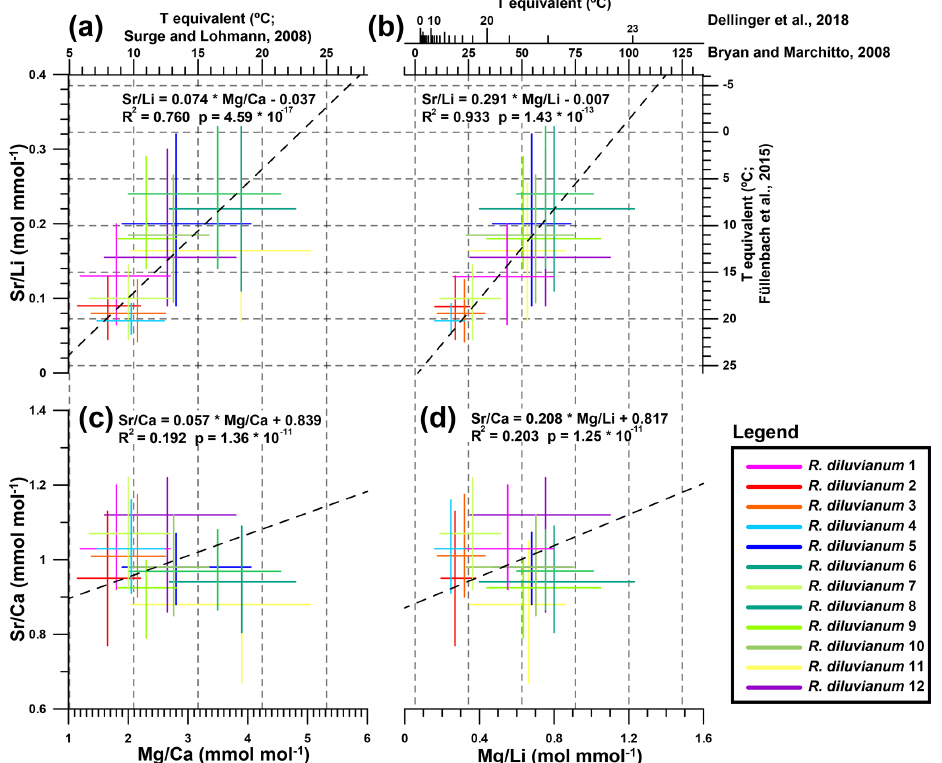
Figure 8. Cross plots showing the extent of interpreted seasonality observed in records of four trace element proxies in all 12 R. diluvianum specimens. Colors of lines of individual shells correspond to colors indicated in Fig. 2. Temperature conversions from previously published regressions of the proxies with temperature are shown on opposite axes, with grey dashed lines corresponding to major tick marks on the temperature scale. (a) Sr / Li plotted against Mg / Ca, showing a strong significant intra-shell correlation. (b) Sr / Li plotted against Mg / Li, showing a strong significant intra-shell correlation due to dominant variations in Li concentration. Note that two different Mg / Li temperature calibrations were explored. (c) Sr / Ca plotted against Mg / Ca, showing weak but significant intra-shell correlation. (d) Sr / Ca plotted against Mg / Li, showing a weakly significant intra-shell correlation. Data for this plot are found in Fig. S13 from de Winter et al.